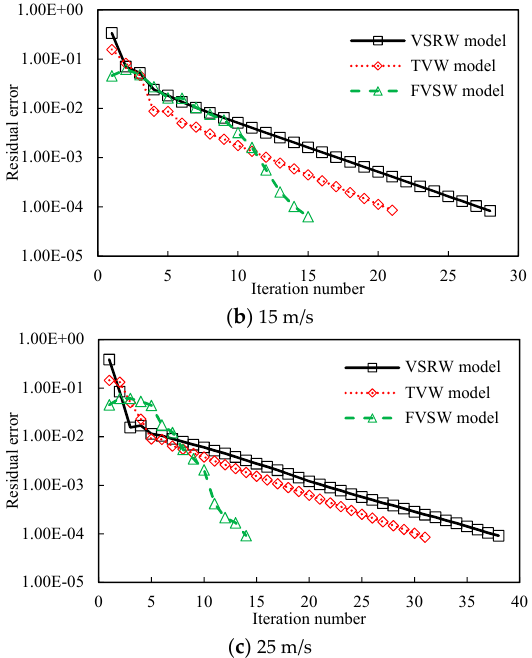
Figure 10. Convergence history of the RMS of the error in the wake geometry.